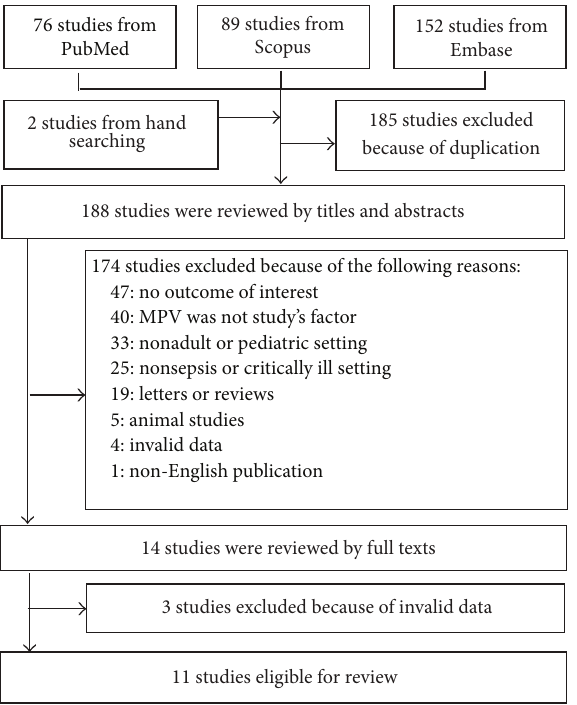
suggested by Wan et al. [12]. All the data were pooled and categorized into survival group and nonsurvival group. Six of eleven studies showed higher MPV in the nonsurvival group than in the survival group at the time of enrollment [18, 19, 22, 24–26]. The pooled mean difference of MPV between nonsurvivors and survivors was 0.17 (95% CI: − 0.04, 0.38); however, there was marked heterogeneity by the random effect model (Chi square = 58.47, degree of freedom: 10, 𝐼 2 : 82.9%, 𝑝 < 0.001 ). See Figure